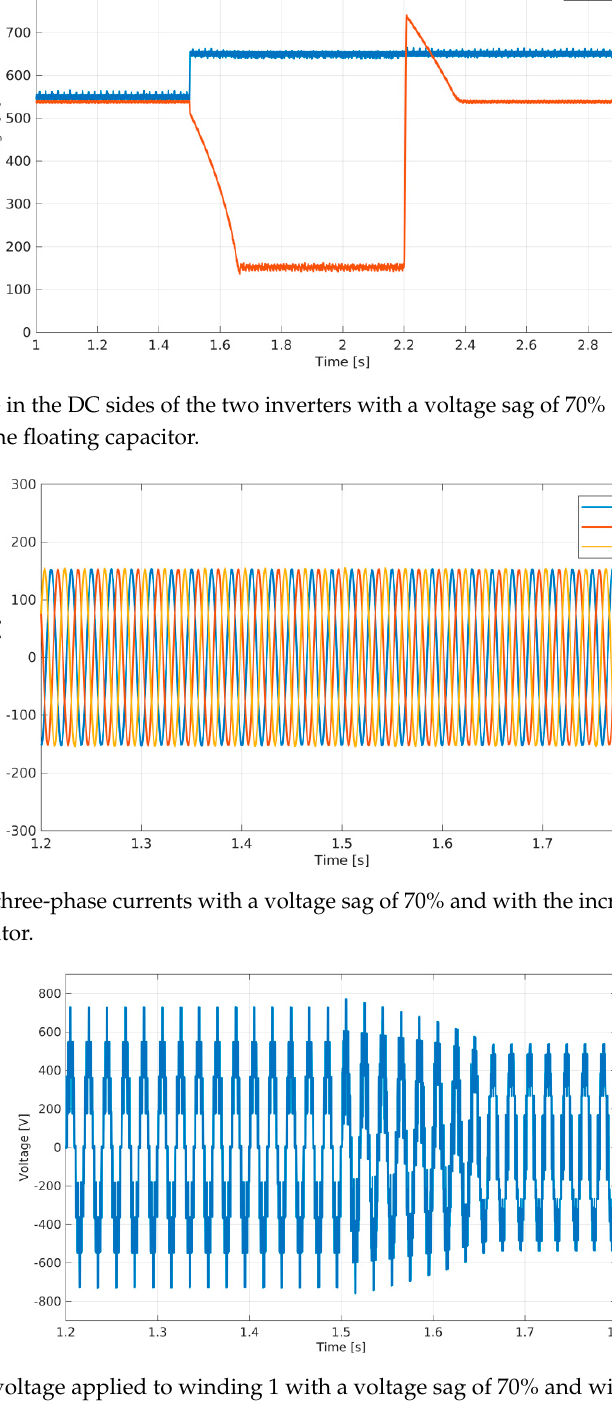
Figure 16. Phase voltage applied to winding 1 with a voltage sag of 70% and with the increase in the voltage of the floating capacitor.